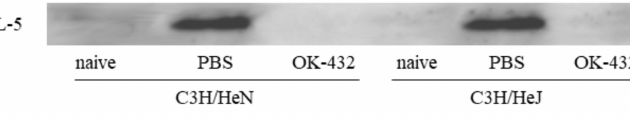
Figure 7. IL-5 expressions of nasal mucosae assessed by Western blot assay, in a murine model of C3H/HeN or C3H/HeJ mice systemically sensitized with OVA and receiving subsequent intranasal challenge of OVA. Naive mice underwent no systemic sensitization. PBS-treated mice were i.p. injected with PBS on day 0 and day 7. OK-432-treated mice were i.p. injected with 100 mg OK-432 on day 0 and day 7. IL-5 expressions were detected in PBS-treated C3H/HeN and C 3H /HeJ mice, but not found in OK-432-treated-mice of both